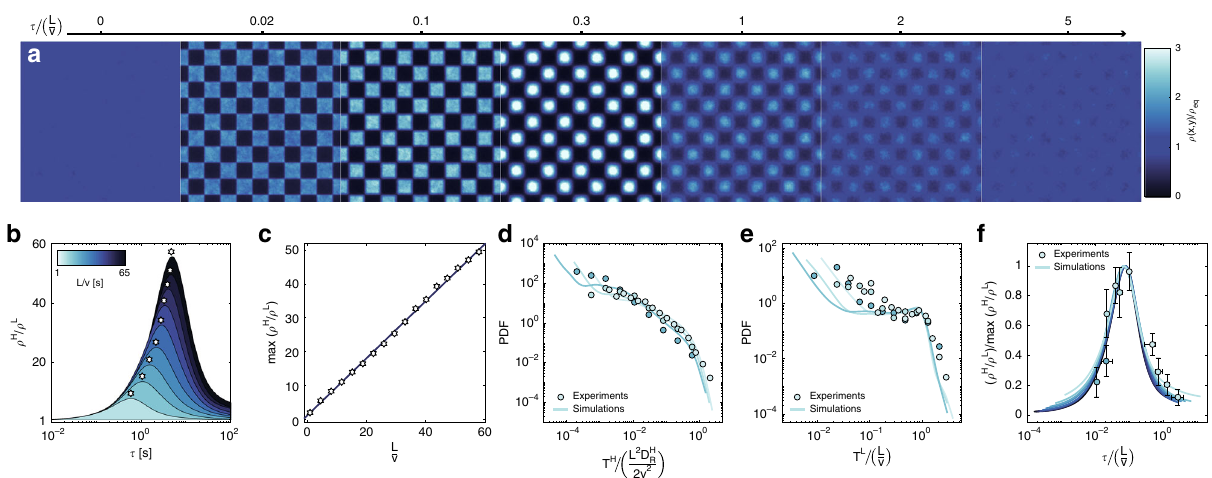
Fig. 5 Emergence of localization for fi nite sampling period τ . a Simulated particle density distribution ρ ( x , y ) for different values of τ ( L / v ) − 1 , rescaled by the uniform distribution ρ e q = 1/ A , where A is the area of the simulation box. ρ e q is recovered for a spatially homogeneous D R or τ = 0. The simulation = 10 rad 2 s − 1 and D L = 0.01 rad 2 s − 1 . The distributions are obtained by binning the positions of 2.5 × 10 4 parameters are v = 3.5 μ m s − 1 , L = 32 μ m, D H R R particles for a simulated time of 900 s, after letting the particles move from their initially random positions for 100 s. Periodic boundary conditions are enforced over a square simulation box of size 10 L × 10 L . b Simulated ratio between the average particle densities in the D H - and D L -regions, ρ H / ρ L , R R as a function of τ for different values of L / v . ρ H / ρ L is calculated as 〈 T H / T L 〉 , where T H and T L are the residence times in the D H - and D L -regions, R R respectively. c Simulated maximum ρ H / ρ L (stars) as a function of L / v , fi tted to a linear model (black line). d – e Simulated and experimental distribution of and the ballistic timescale L / v , respectively. f Experimental and simulated ρ H / ρ L as a d T H and e T L , normalized by the effective diffusive timescale L 2 D H R 2 v 2 function of τ ( L / v ) − 1 for different L / v , rescaled by the corresponding maximum. Lines and circles in d – f are color-coded based on L / v according to colormap of b . Error bars denote 95% con fi dence (Fig. 5b). In particular, the maximum ρ H / ρ L ratio is a linearly